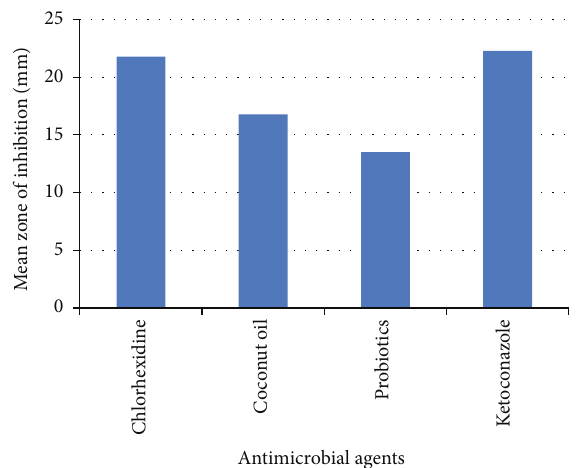
Figure 3: Mean of zone of inhibition of the antimicrobial agents against Candida albicans